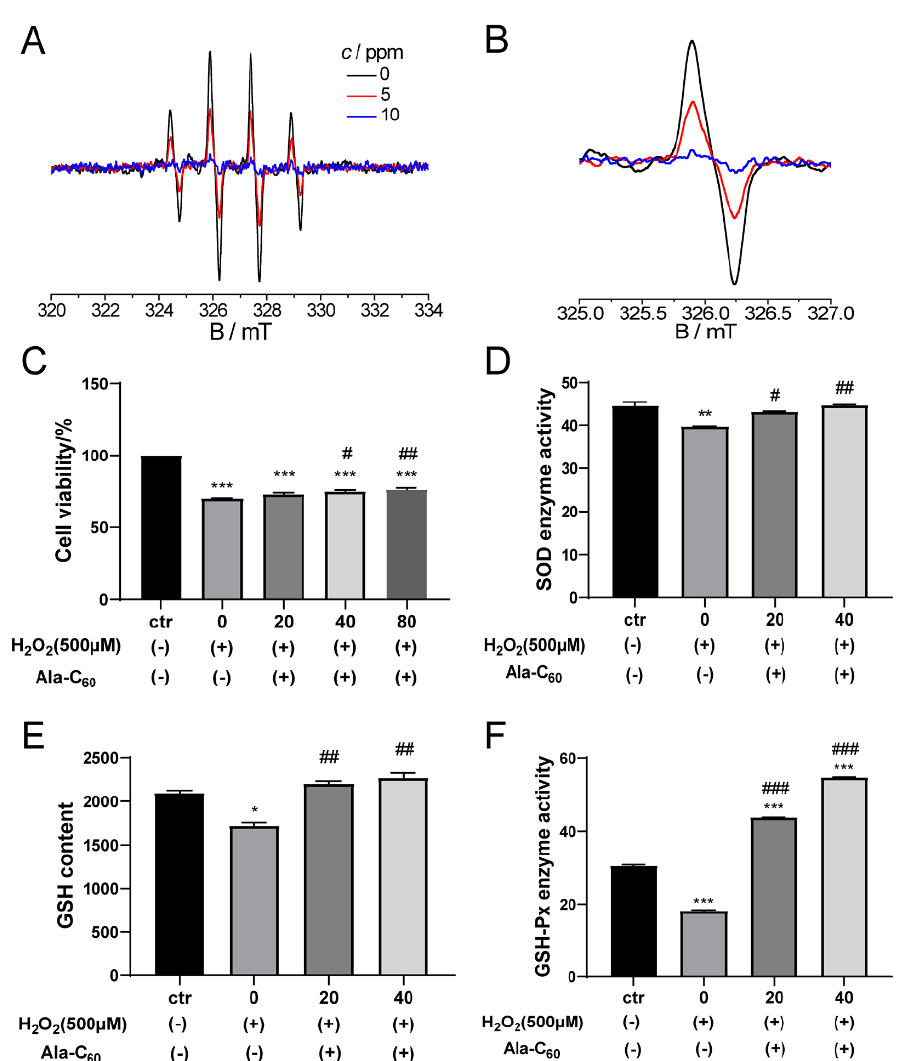
Figure 6. ( A ) ESR spectra of 357 µ M H 2 O 2 aqueous solution in the presence of different concentrations of Ala-C 60 . Each solution contains 7.14 mM DMPO as the probe. ( B ) Magnified spectra in the range of 325.0–327.0 mT (the peak indicated by the ellipse in A ). ( C – F ) Cell viability ( C ), intracellular superoxide dismutase activity ( D ), intracellular glutathione content ( E ), and intracellular